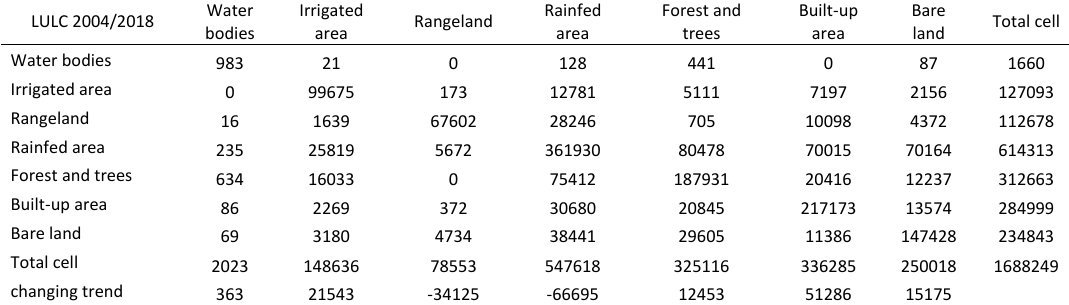
Table 6f: Transition area of each class for 2004-2018 (round three)